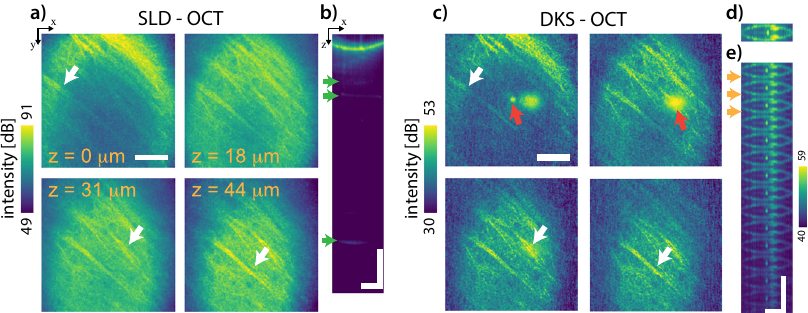
Fig. 4 Qualitative performance comparison of sources for ex vivo cerebral tissue imaging. En-face images at different depths of a slice of brain tissue were obtained with both a superluminescent diode (SLD) and a dissipative Kerr soliton (DKS) source a and c respectively, revealing the presence of highly scattering neuronal fi bers (pointed by blue arrows). The en-face views obtained with the DKS source also contain additional features, pointed by red arrows, such as bright vertical stripes, circular ring patterns, and higher intensity regions. The cross-sections for both SLD and DKS imaging b and d , respectively, highlight the imaging ’ s fi eld curvature, highly re fl ective structures below the sample (pointed by white arrows) and the presence of an ambiguity range when imaging with the discrete DKS source (pointed by red arrows). Scalebars: 50 μ m ( a and c ), 100 μ m ( b , d and e